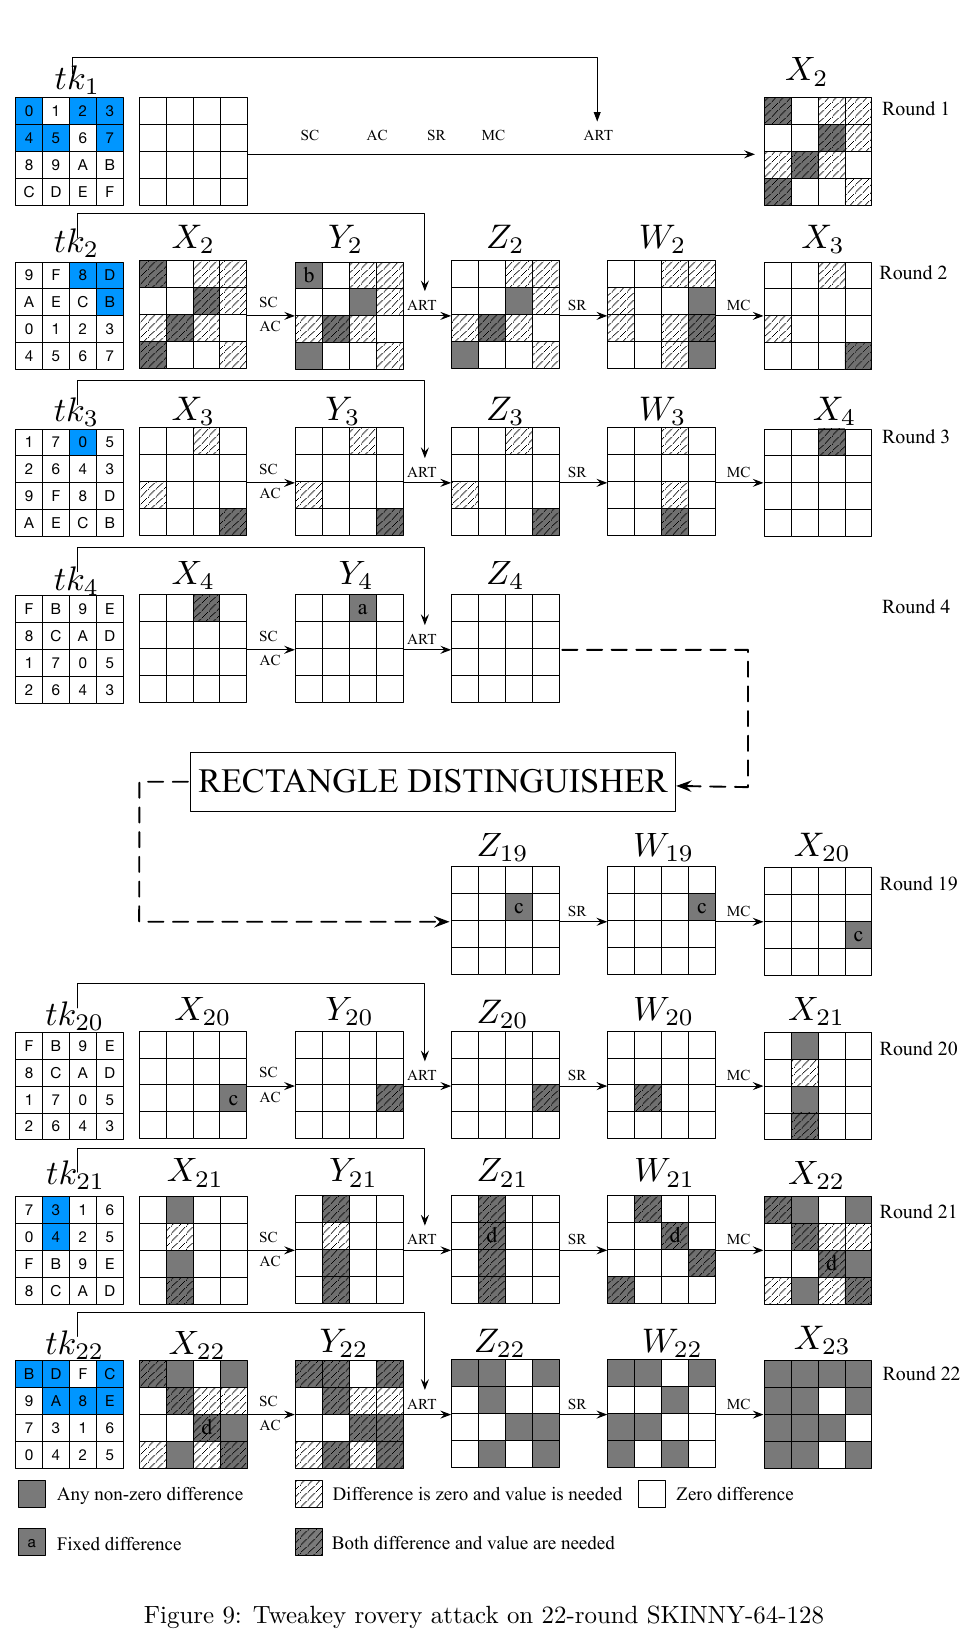
Figure 9: Tweakey rovery attack on 22-round